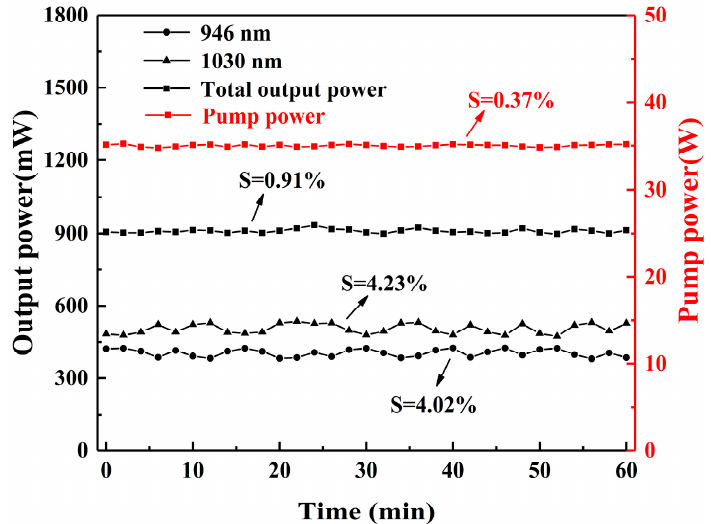
Figure 9. The power stability of the 946/1030 nm LG 01 mode vortex laser and 808 nm LD with time. The trend of the beam quality factors M 2 of the 946/1030 nm LG 01 mode vortex laser with incident pump power as well as time is given in (a) and (b) in Figure 10, respectively. The theoretical value of the beam quality factor M 2 for the LG 01 mode vortex laser is 2. When the pump power is 13 W to 20 W, the beam quality factor M 2 for the 946 nm LG 01 mode vortex beam is in the range of 2.20 to 2.32, and the beam quality factor M 2 for the 1030 nm LG 01 mode vortex beam is in the range of 2.14 to 2.27. The beam quality